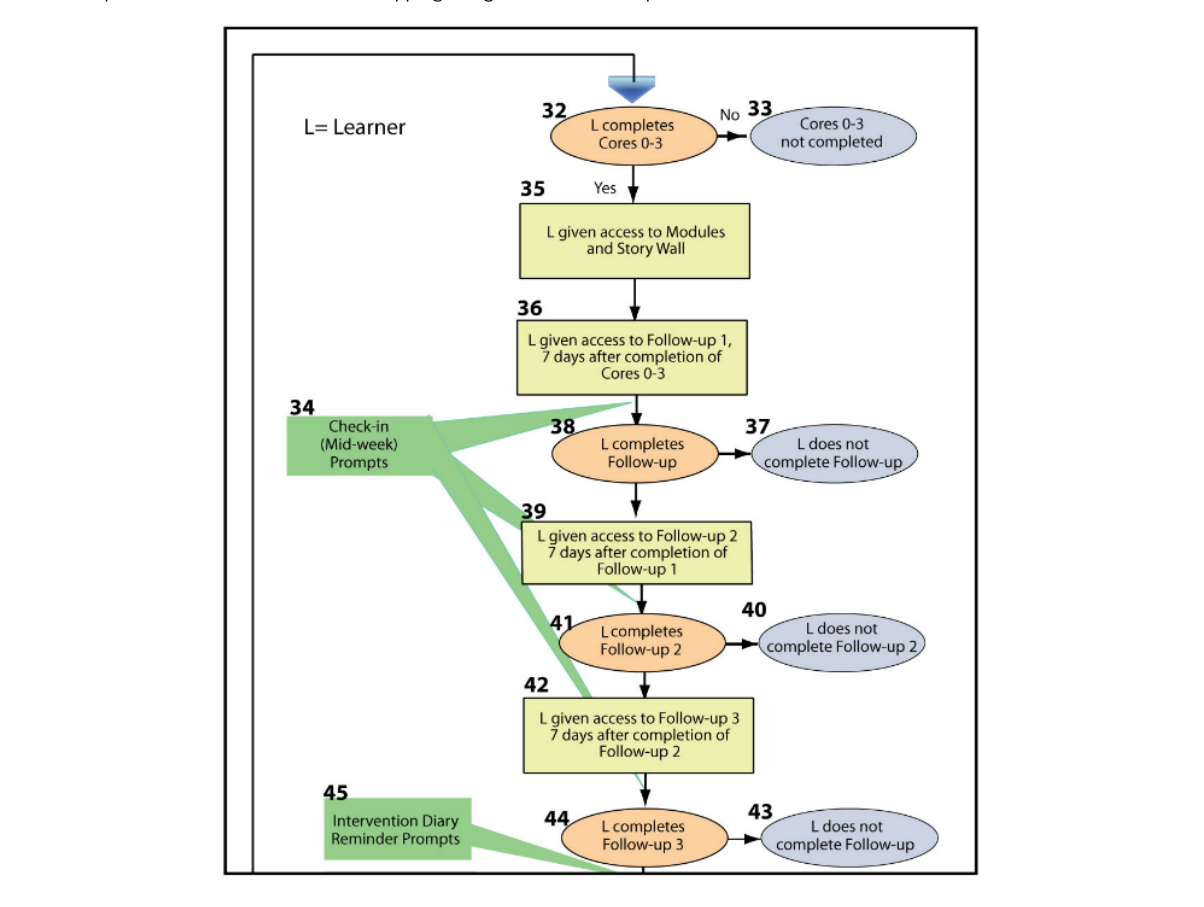
Figure 5. Example of instructional curriculum mapping. Program overview: